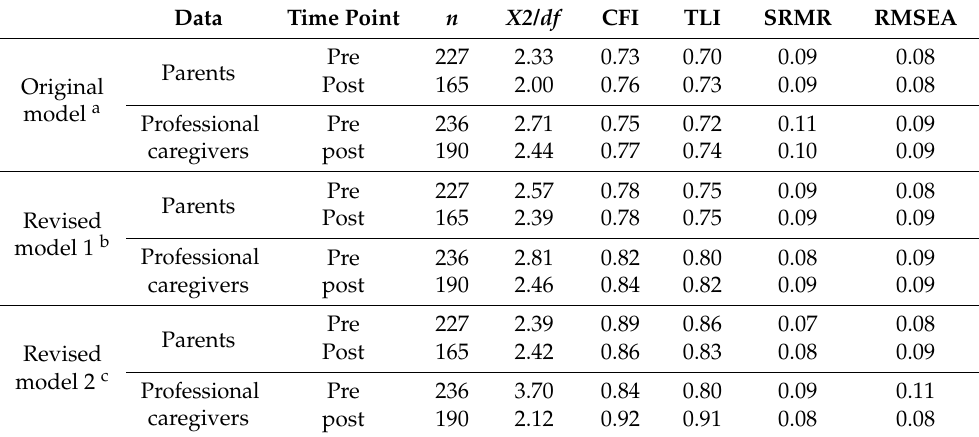
Table 3. Model fits of the confirmatory factor analyses for parent and professional caregiver data for both time points.